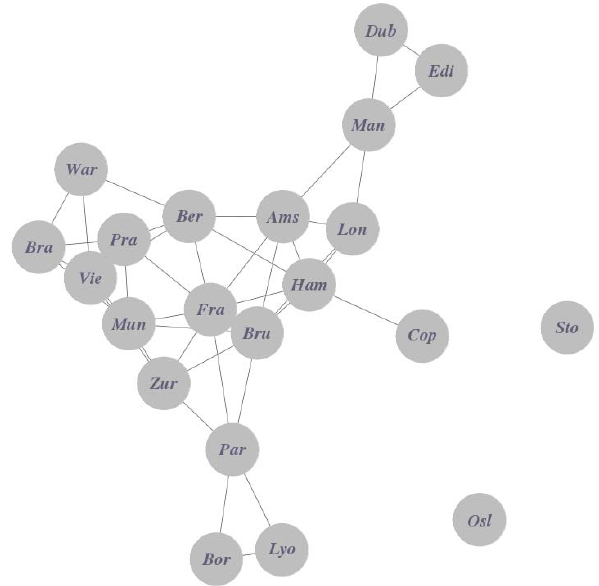
Fig. 6. The graph synthesizes the strongest tail dependences be- tween European capitals. Each circle (vertex) represents a city and connections are drawn for pair of cities whose tail dependence is bigger than cut off value χ = 0 . 4 . The graph can also be inter- preted as a representation of the triangular matrix of tail dependence coefficients between pairs of cities. Graph orientation is randomly